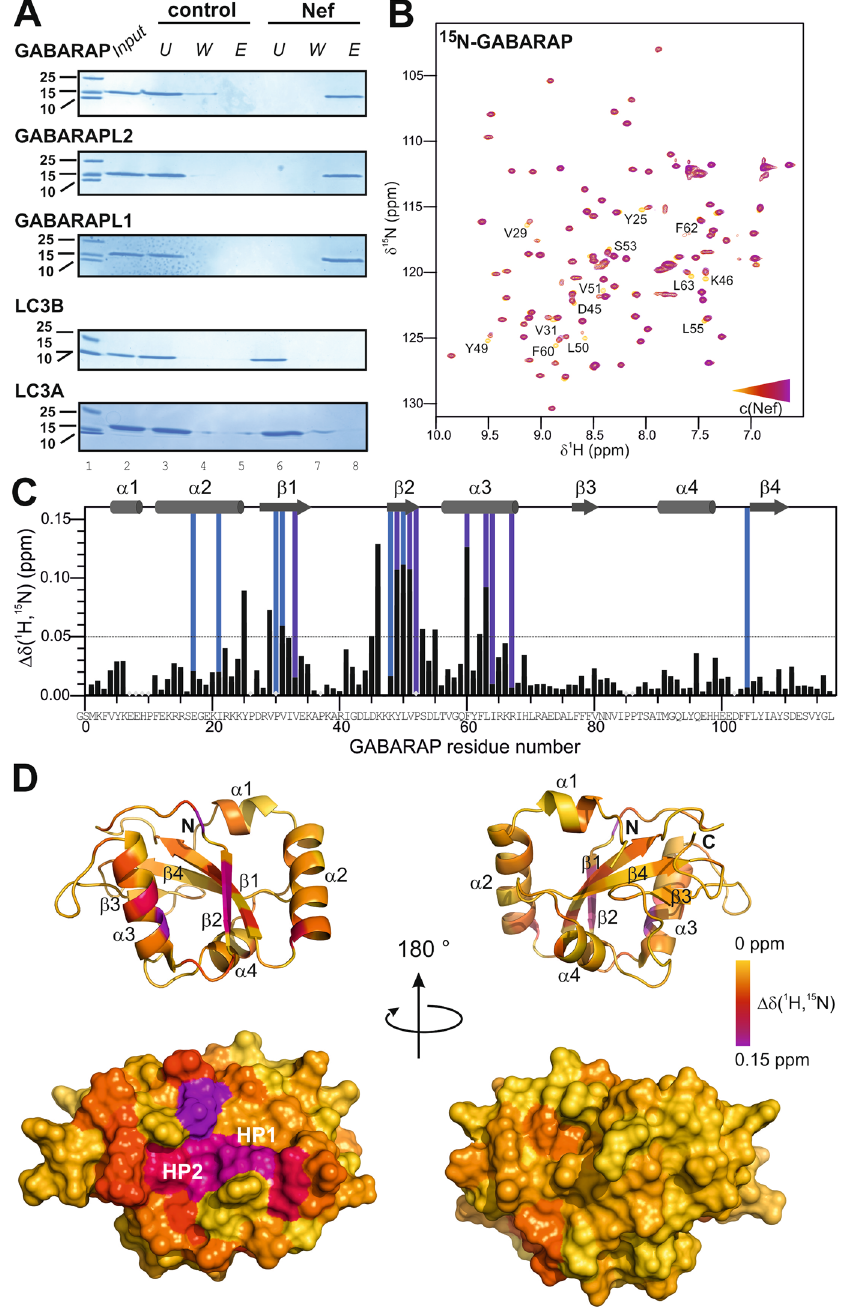
Figure 2. Nef selectively binds to GABARAPs in a direct manner and contacts the canonical ligand binding site of GABARAP. ( A ) Nef-conjugated or free control Sepharose beads were incubated with the purified recombinant ATG8 paralogs listed. The input, the unbound material of the flow through (U), the wash (W) fractions and the eluate (E) fractions have been analyzed by SDS-PAGE and CBB staining. Full-length gels are presented in Supplementary Fig. 4. ( B ) Mapping the Nef binding site on GABARAP by NMR titration experiments: overlay of 2D 1 H- 15 N-HSQC spectra of [ U - 15 N]-GABARAP (yellow) with increasing amounts of Nef (red and purple). GABARAP residues affected upon Nef binding are labelled. For better visibility the first titration step (ratio of 1:0.5 for [GABARAP]:[Nef]) has been omitted from this figure. ( C ) Combined chemical shift changes Δδ ( 1 H, 15 N) as a function of the GABARAP sequence. Secondary structure elements are shown on top of the diagram. Residues belonging to the hydrophobic pockets 1 and 2 are highlighted in light blue and blue, respectively. Residues for which no chemical shift changes could be determined and prolines are marked by a grey diamond. A cut-off of 0.05 ppm (continuous horizontal line) was used for significance. ( D ) Mapping of the Nef interaction site on a schematic representation of the secondary structure (top) and the molecular surface (bottom) of GABARAP (PDB ID: 1KOT). Residues strongly affected upon Nef binding are marked in purple, whereas non-interacting residues are shown in